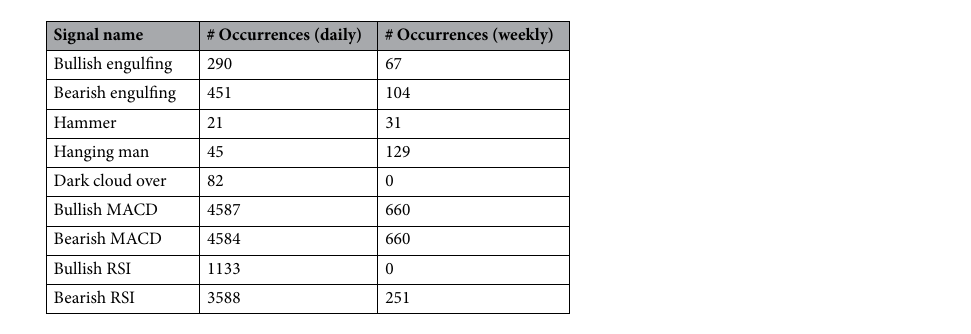
Table 3. Summary of the number of observations of technical analysis signals in pooled 120,000 sample of 28 stocks over 10 years used in our study from Yahoo Finance 20 .